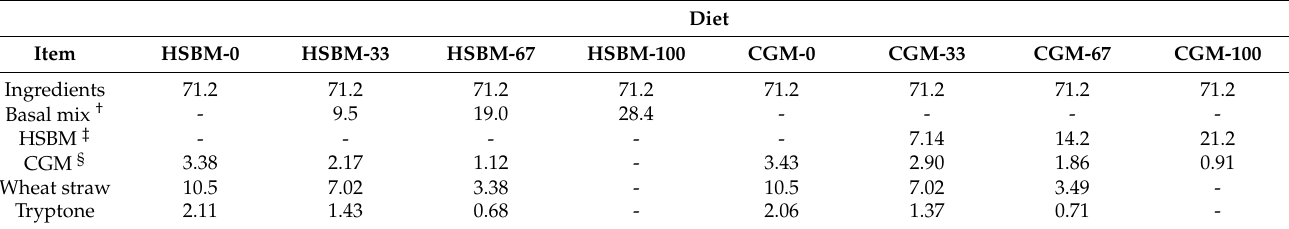
Table 1. Ingredients and chemical composition of diets (% dry